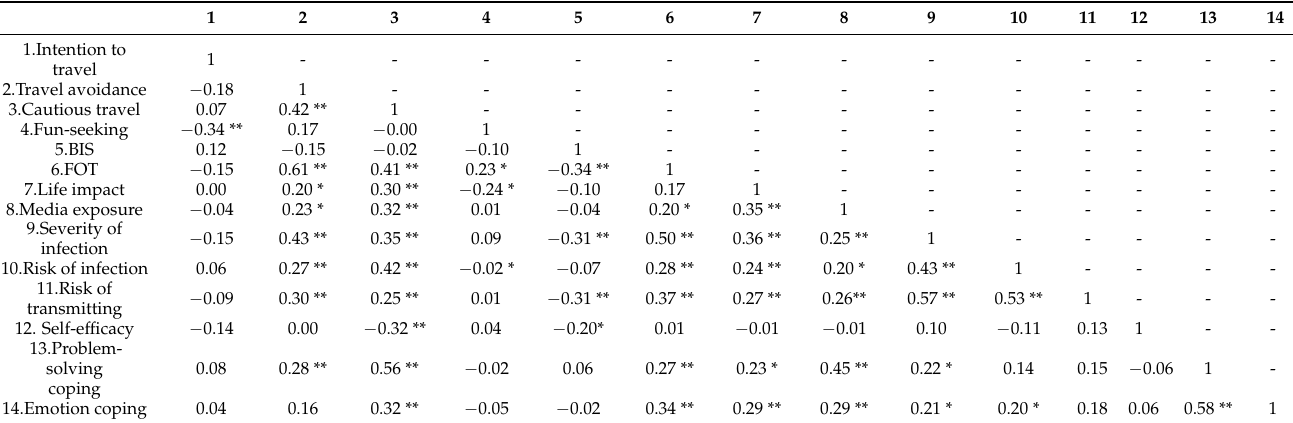
Table 2. Correlation coefficients between travel behaviors and risk, media exposure, severity of disease, coping, and personality variables.